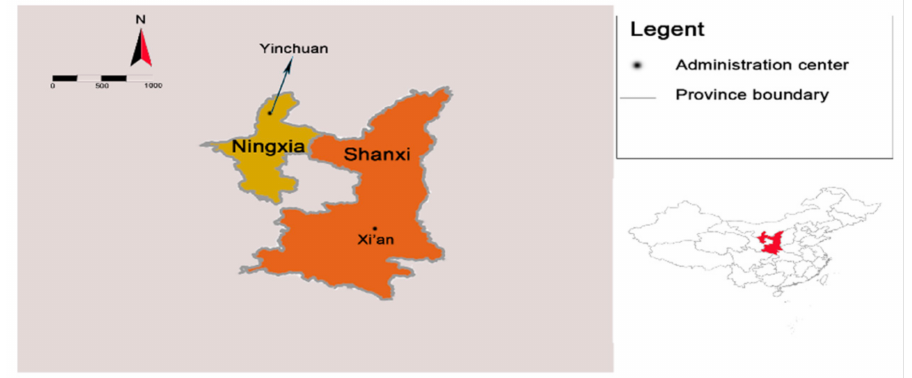
Figure 3. Map of the study